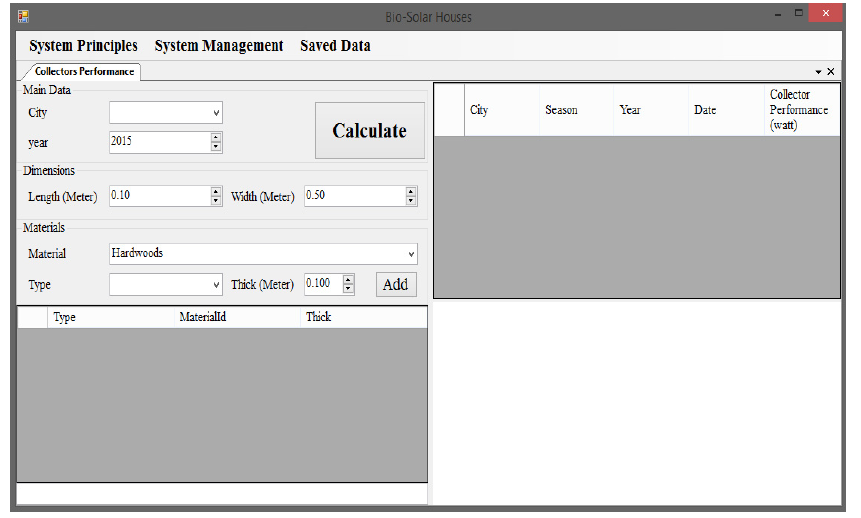
Figure 6. Solar collectors’ form in the model.